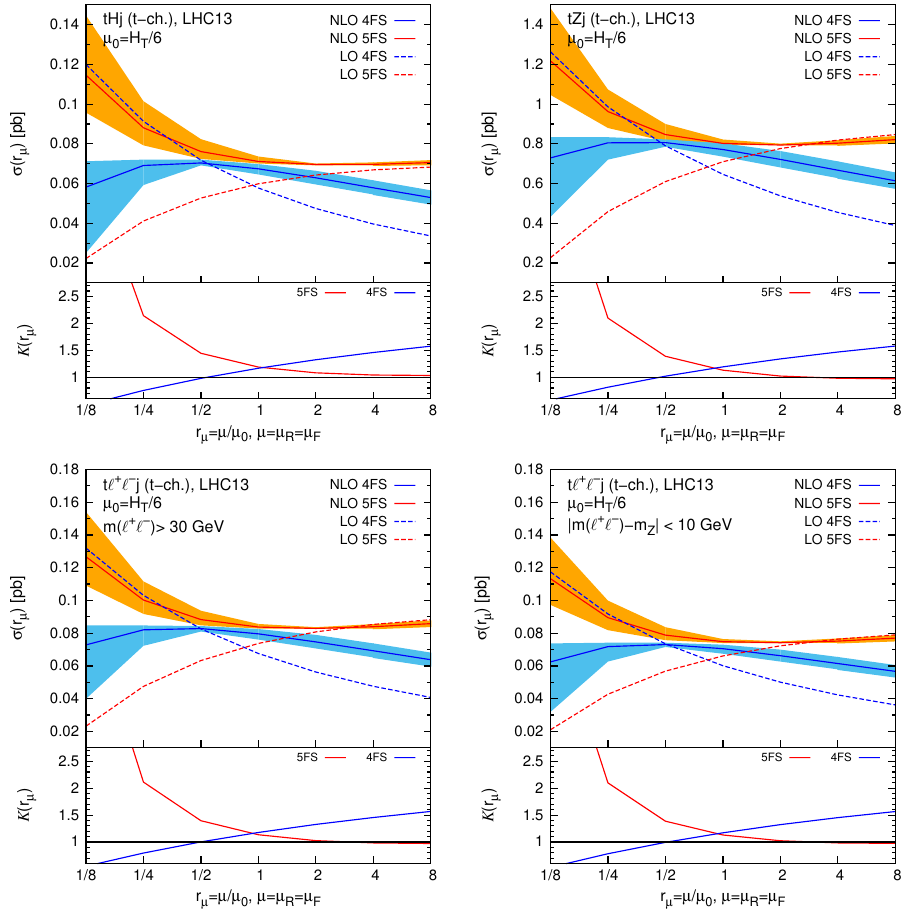
Figure 2 . Scale dependence of total cross sections for tHj production (top-left), tZj production (top-right) and t‘ + ‘ (cid:0) j production for the \inclusive" (bottom-left) and Z -peak (bottom-right) case in the 4FS and